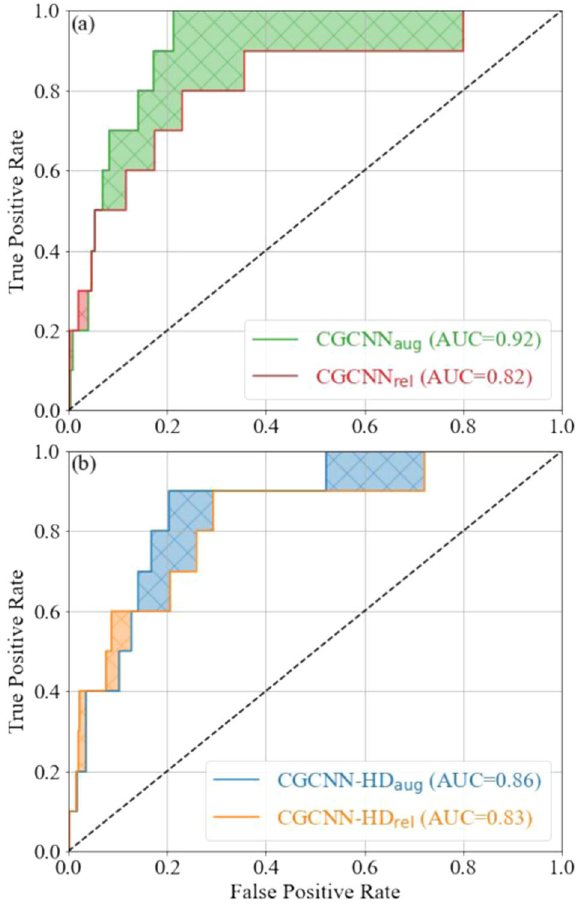
Fig. 4 Receiver operating characteristic curve. Figure displays the a CGCNN and b CGCNN-HD ability to classify stable structures when applied to unrelaxed structures. The x -axis is the fraction of unstable structures classi fi ed as stable. The y -axis is the fraction of stable structures classi fi ed as stable. The aug subscript represents the model was trained on the augmented data. The rel subscript represents the model was trained on the relaxed data. The dashed- black line represents a random classi fi er. The shaded regions signify where a model is performing better. The area under curve (AUC) is reported for all models.